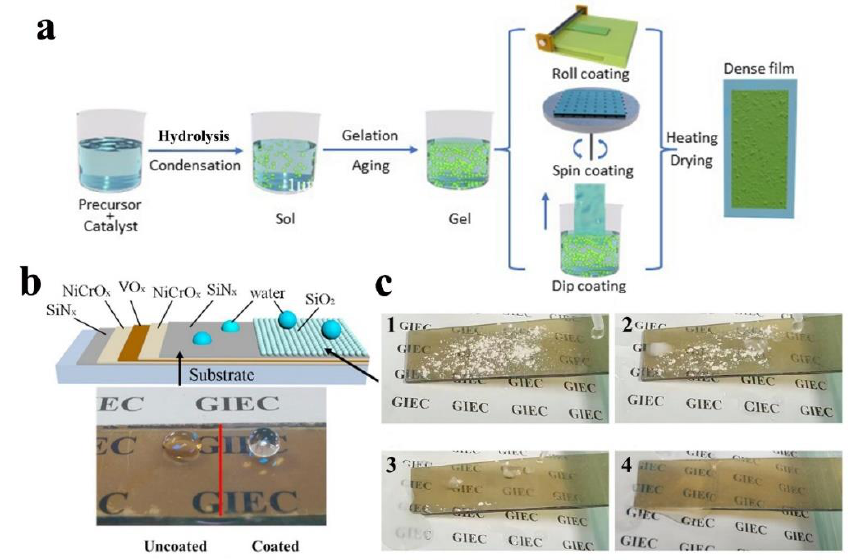
Figure 12. ( a ) Schematic diagram of the preparation of sol-gel. ( b ) Schematic of multi-layer structure coating. ( c ) Easy-cleaning property of the composite films, reproduced with permission from Ref. [151].